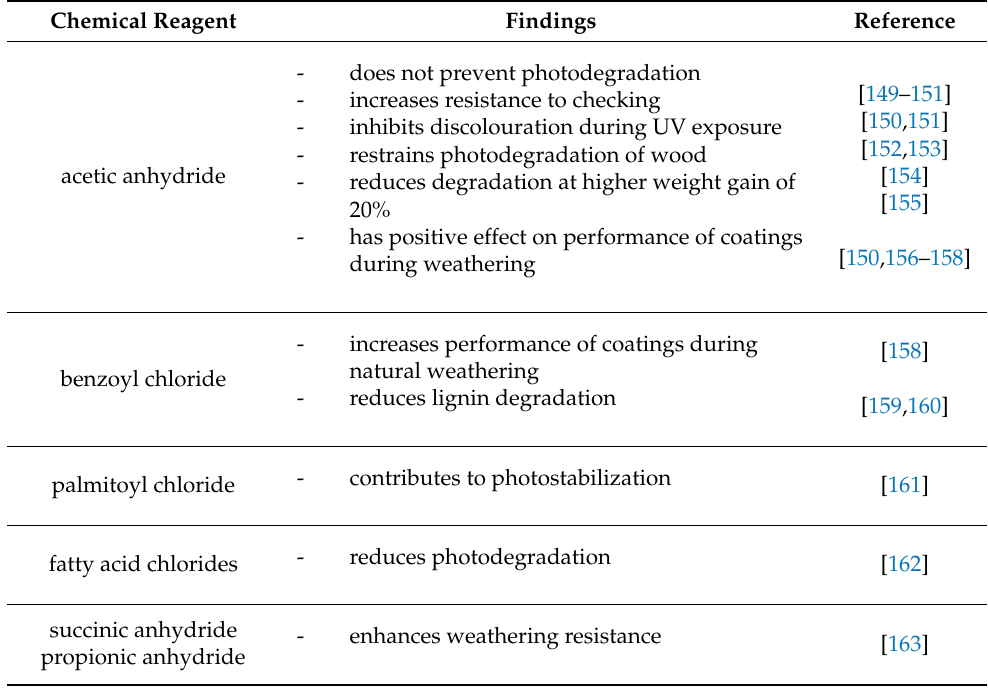
Table 1. Findings on the protection of chemical reagents against wood